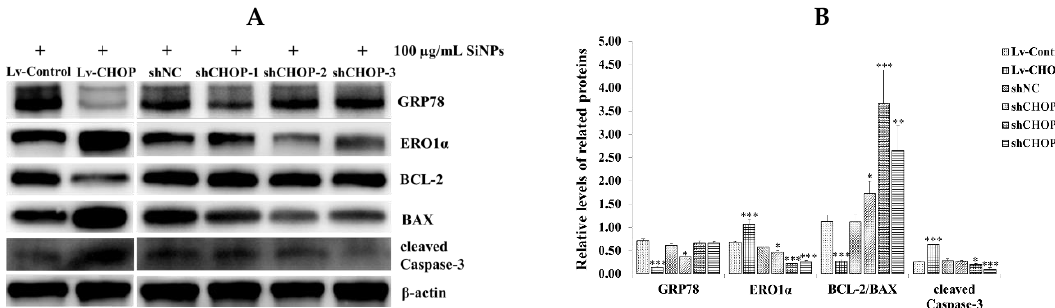
Figure 8. Effect of CHOP on the expression of the ER stress and apoptosis-related proteins in RAW 264.7 macrophage cells. ( A , B ) The stably expressed RAW 264.7 macrophage cells were exposed to 100 µg/mL SiNPs for 12 h. The expression of GRP78, CHOP, ERO1α, BCL-2, BAX, and cleaved Caspase-3 were detected via western blot analysis. The analyses of the band intensity on the films are presented as the relative ratio of target proteins to β-actin, respectively. The statistical analysis is shown in the bar graph. Data are presented as the mean ± SDM of three independent experiments. Statistically different from the control is marked with asterisks (* p < 0.05, ** p < 0.01, and *** p < 0.001).